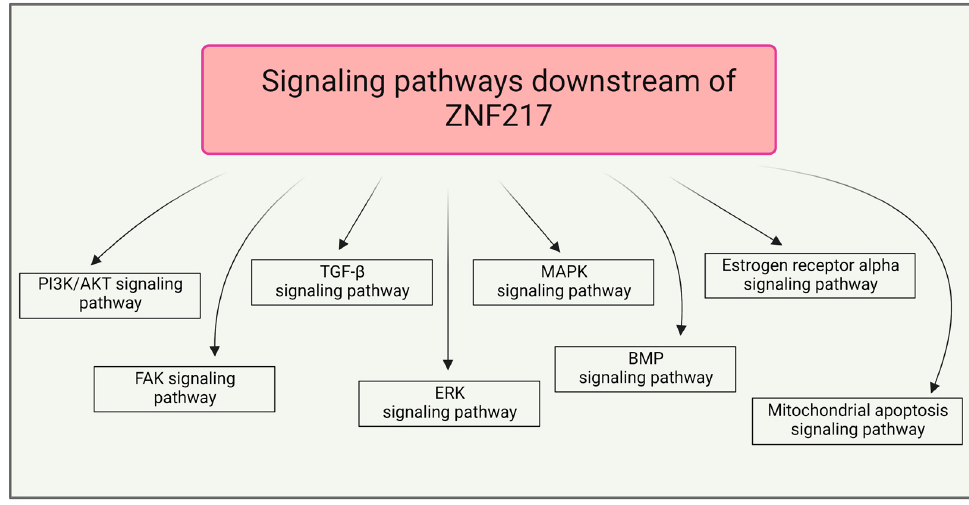
Figure 1. Signaling pathways regulated by ZNF217 and involved in ZNF217-driven functions in tumor progression. Created with Biorender.com.